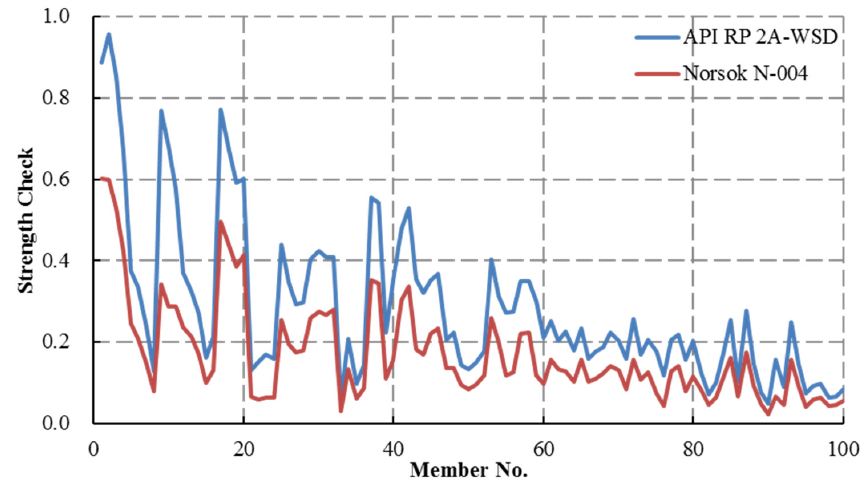
Figure 23. Member Strength Check (Case 5).